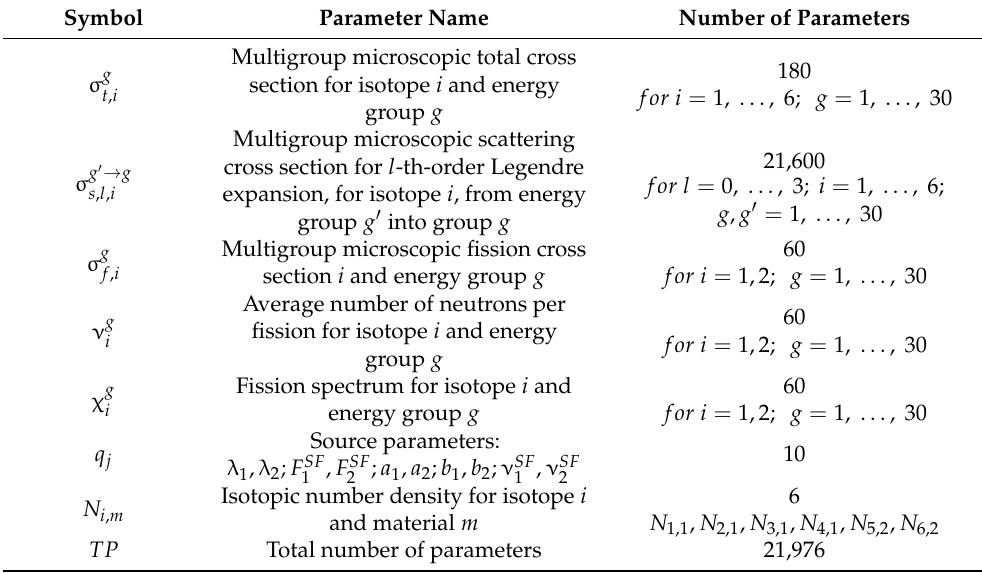
180 for i = 1, . . . , 6; g = 1, . . . , 30 21,600 for l = 0, . . . , 3; i = 1, . . . , 6; g , g (cid:48) = 1, . . . , 30 60 for i = 1,2; g = 1, . . . , 30